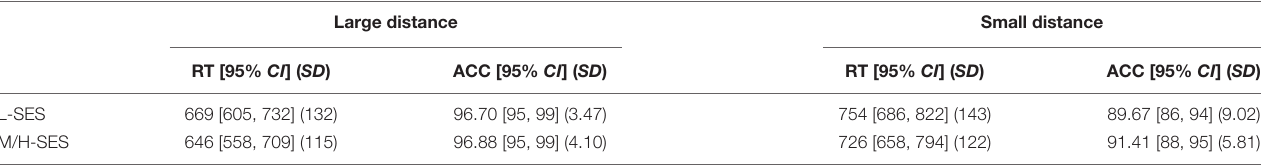
TABLE 2 | The average reaction time (RT, ms) and accuracy (ACC, %) in different conditions of children with different